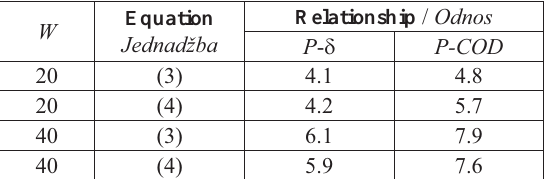
Table 1 Additional crack length ∆ derived by statistically comparing K values obtained from SENB and DCB tests Ic (unit = mm) Tablica 1 . Dodatna duljina pukotine ∆ dobivena statističkom usporedbom vrijednosti K ustanovljene SENB Ic testom i DCB testom (jedinica